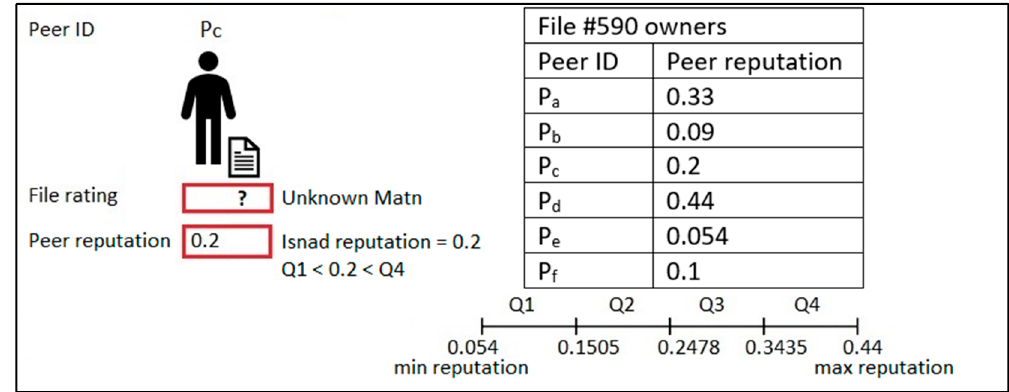
Figure 5. Good Isnad.